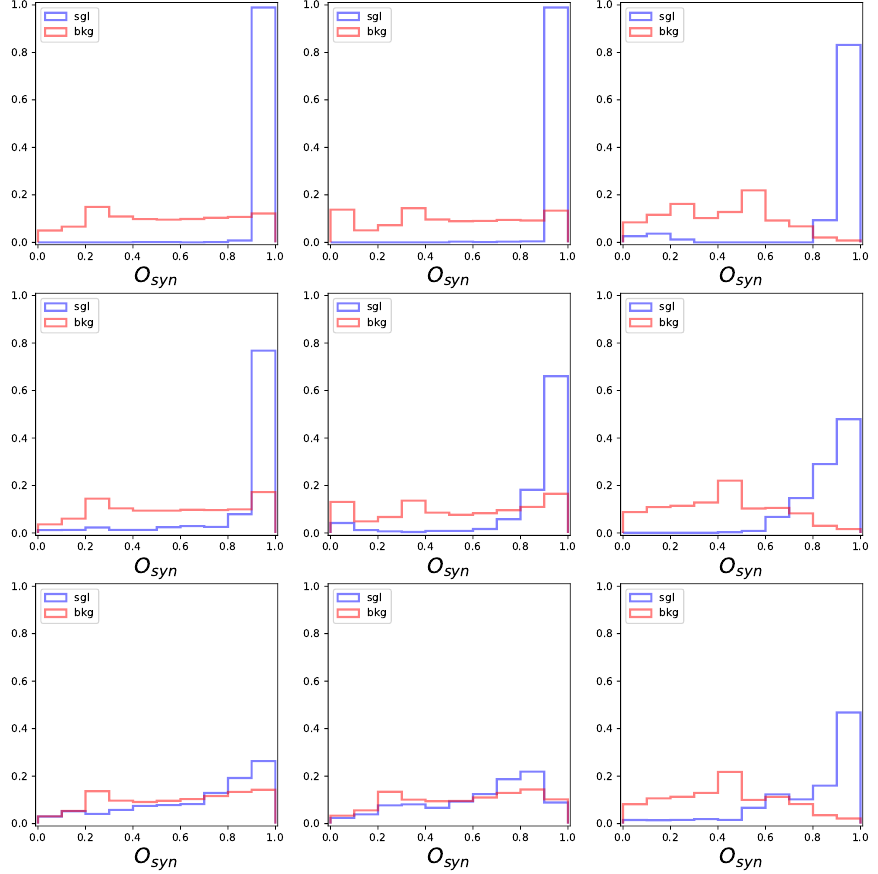
Figure 6 . Novelty score according to O syn for the 2D Gaussian testing samples corresponding to the same BPs as in figure